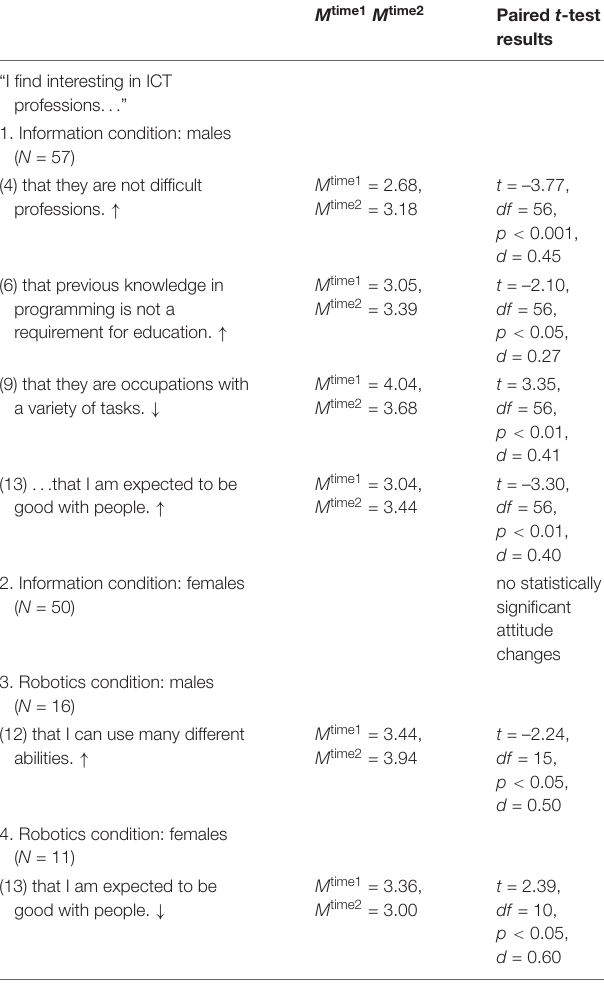
TABLE 8 | Attitude change after interventions a .